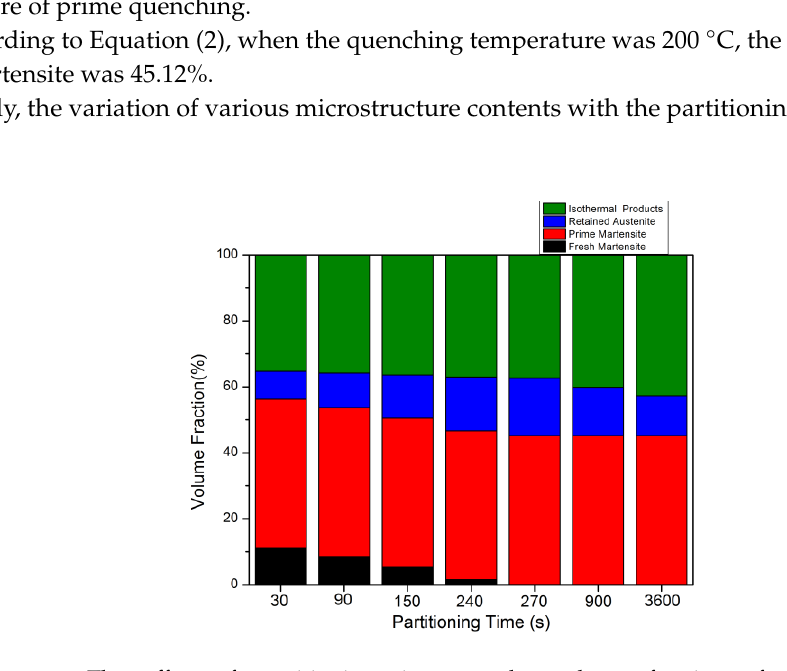
Figure 6. The effect of partitioning time on the volume fraction of the individual microstructural